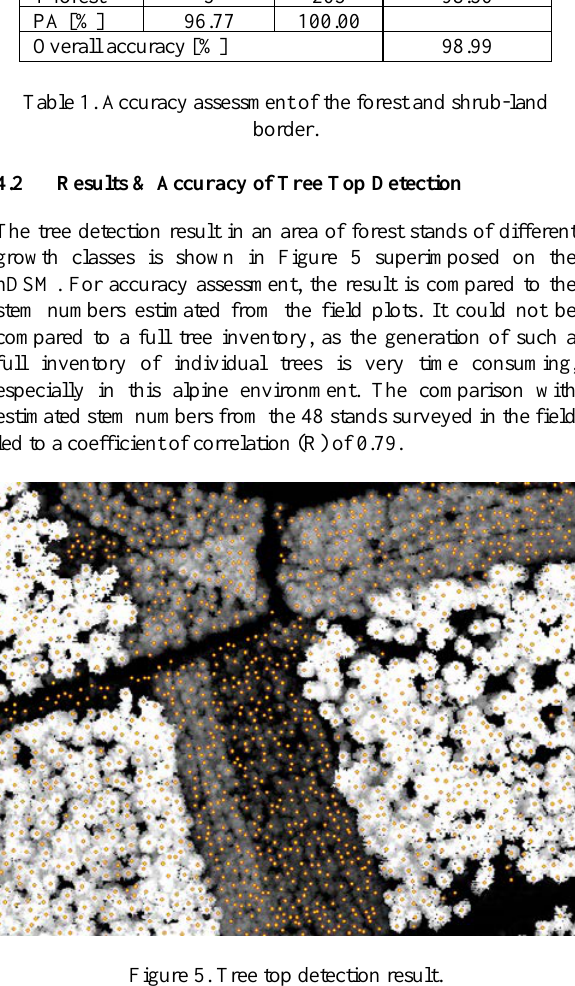
Figure 5. Tree top detection result.